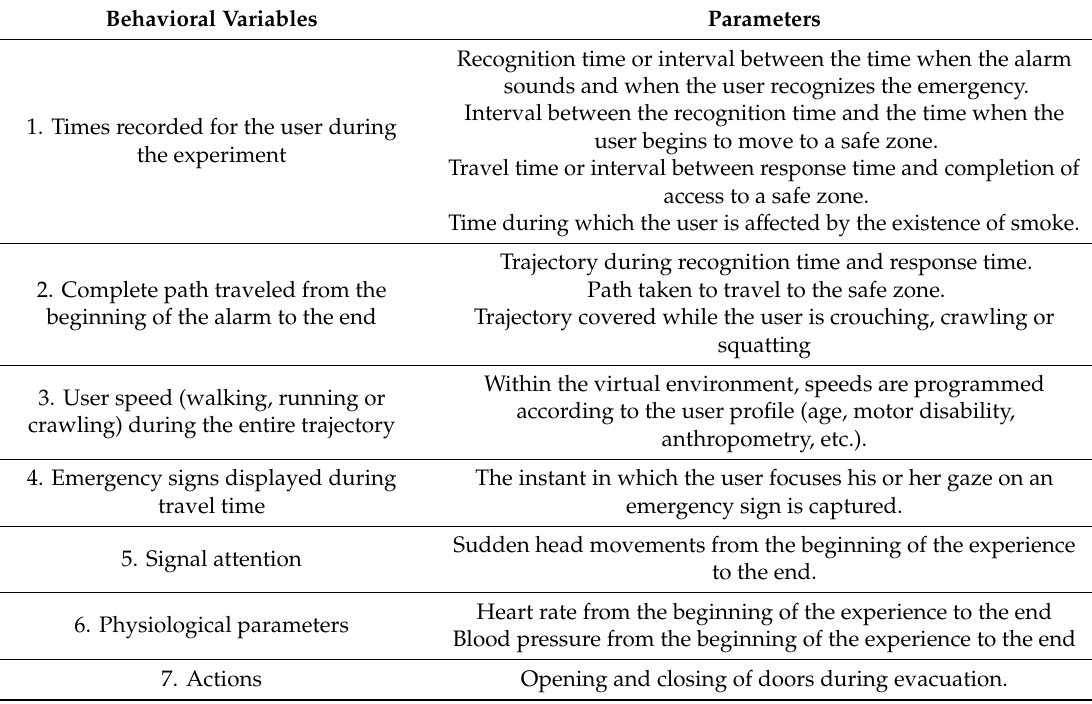
Table 3. Behavioral variables identified in the